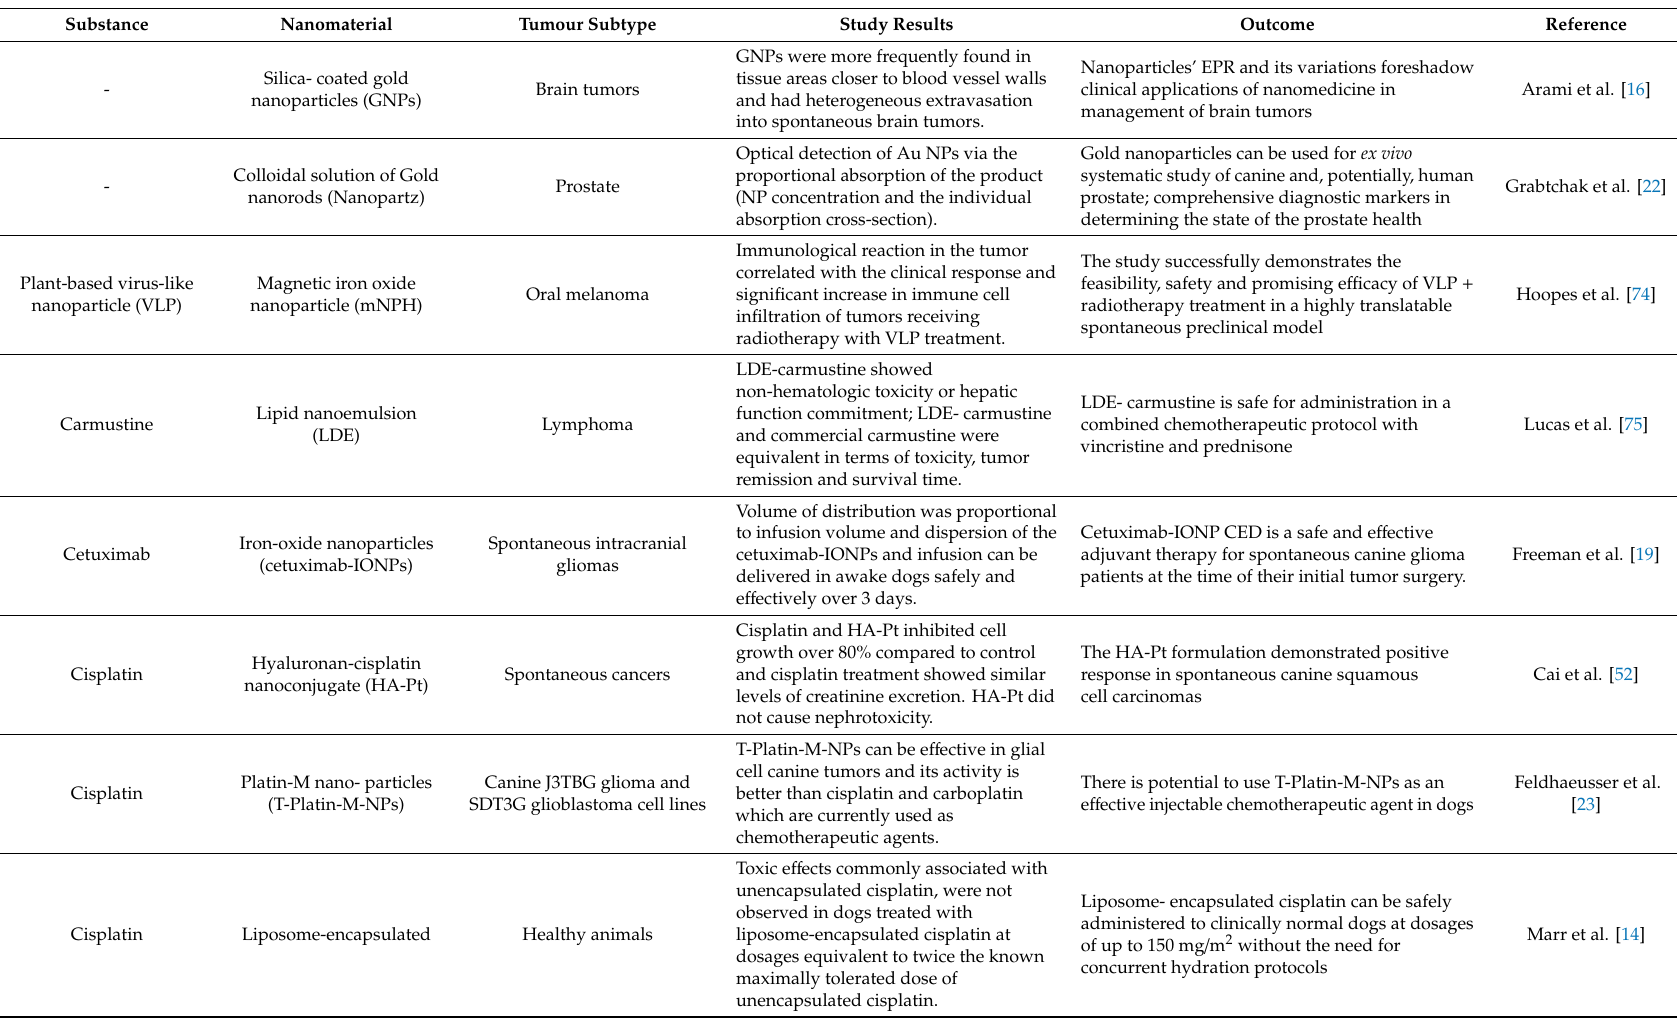
Table 1. Studies describing use of drug delivery vehicles in dogs depending on the chosen